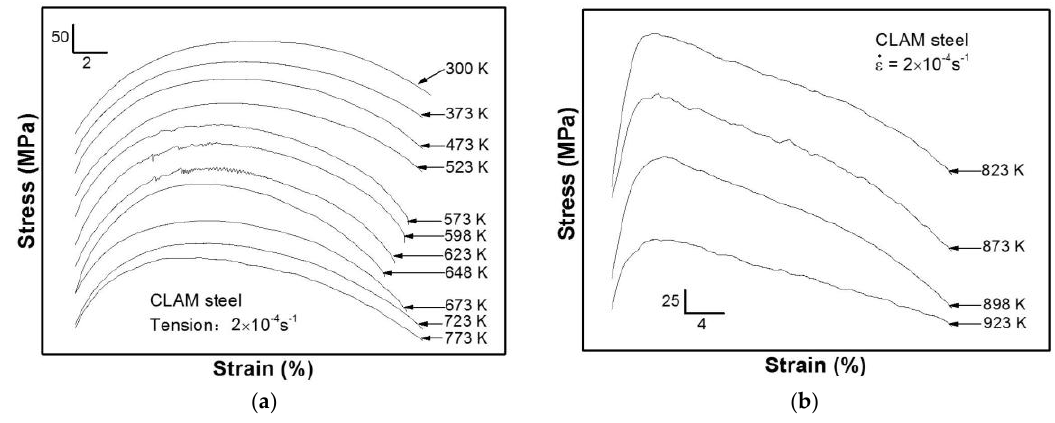
Figure 1. Engineering stress-strain curves of China low activation martensitic (CLAM) steel at different test temperatures, (a) 300–773 K, (b) 823–923 K, at an initial strain rate of 2 × 10 −4 s −1 .